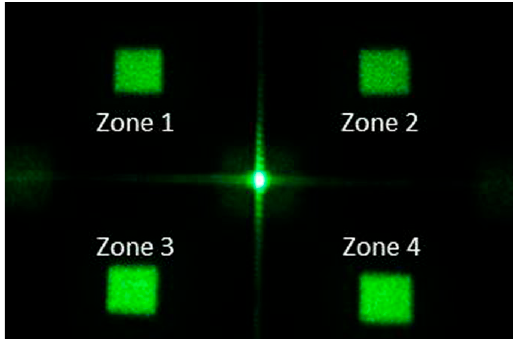
Figure 7. Diffractive image used to evaluate the speckle contrast of integrated images.